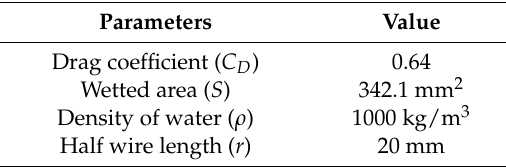
Table 2. Experimental parameters of the test